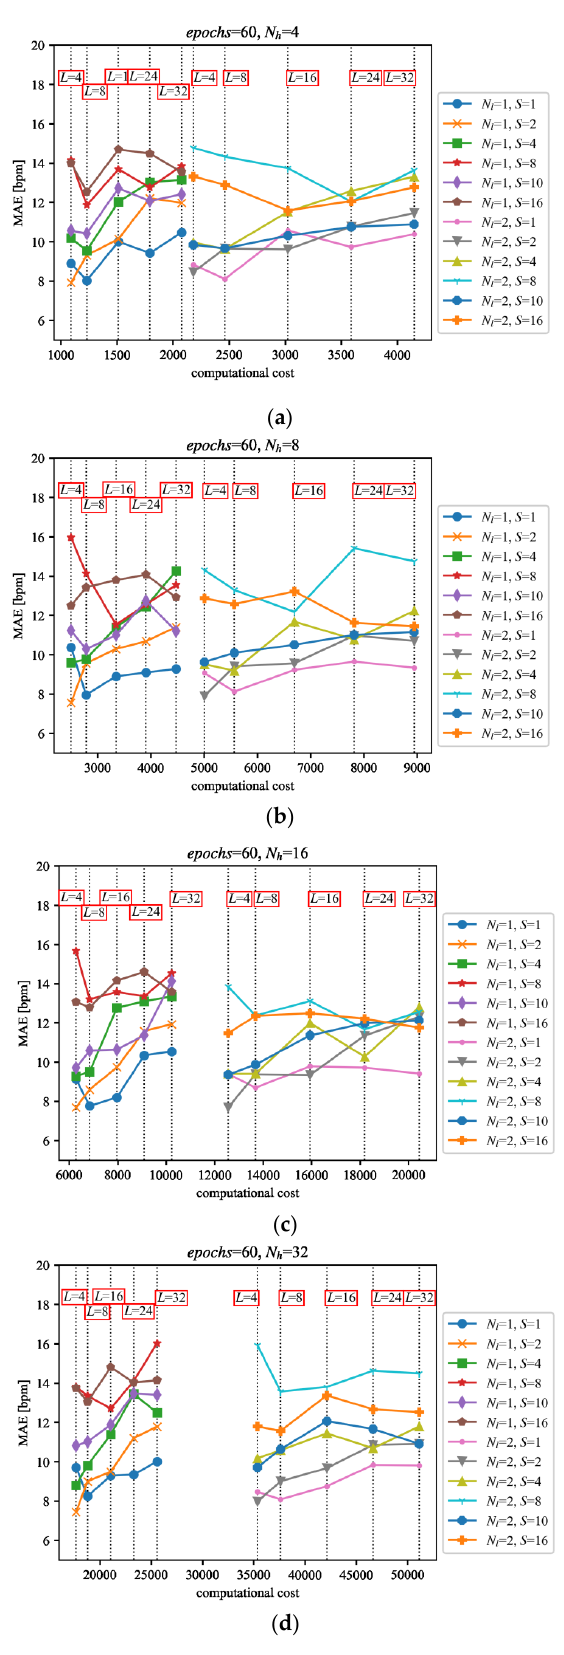
Figure 13. Results of the tests of the LSTM network variants on the PPG dataset [24], trained on the dataset described in Section 4 for the following parameter values: ( a ) N h = 4, ( b ) N h = 8, ( c ) N h = 16 and ( d ) N h = 32. The evaluation results (vertical axis) were confronted with the computational costs (horizontal axis) estimated as the approximate number of basic maths operations [27].